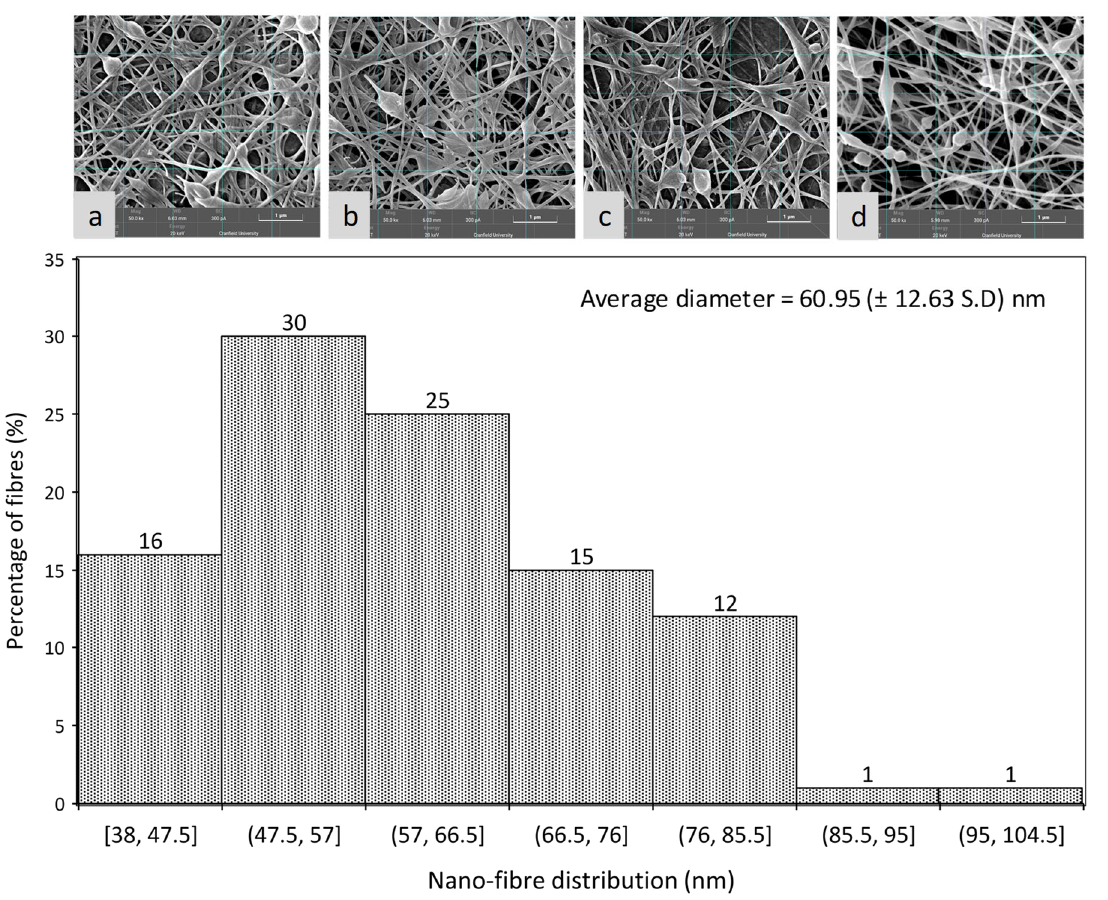
Figure 9. Nanofibre diameter distribution; SEM micrographs for sample S1; ( a ) – ( d ) different locations of S1 sample